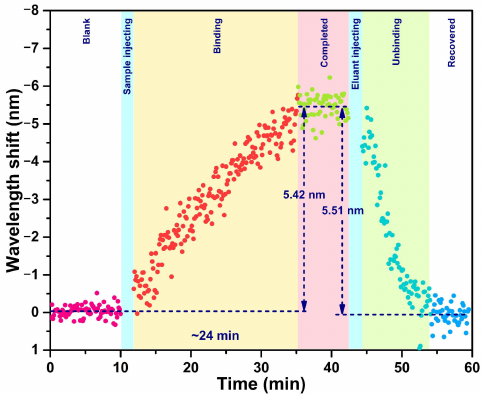
Figure 7. Dynamic response of the resonant wavelength shift of the HGMS with LC sensitization to the binding and unbinding processes of the cTnI-C antigen—antibody from 0 to 20 ng/mL. The different colored data points represent the resonant wavelengths at different detection